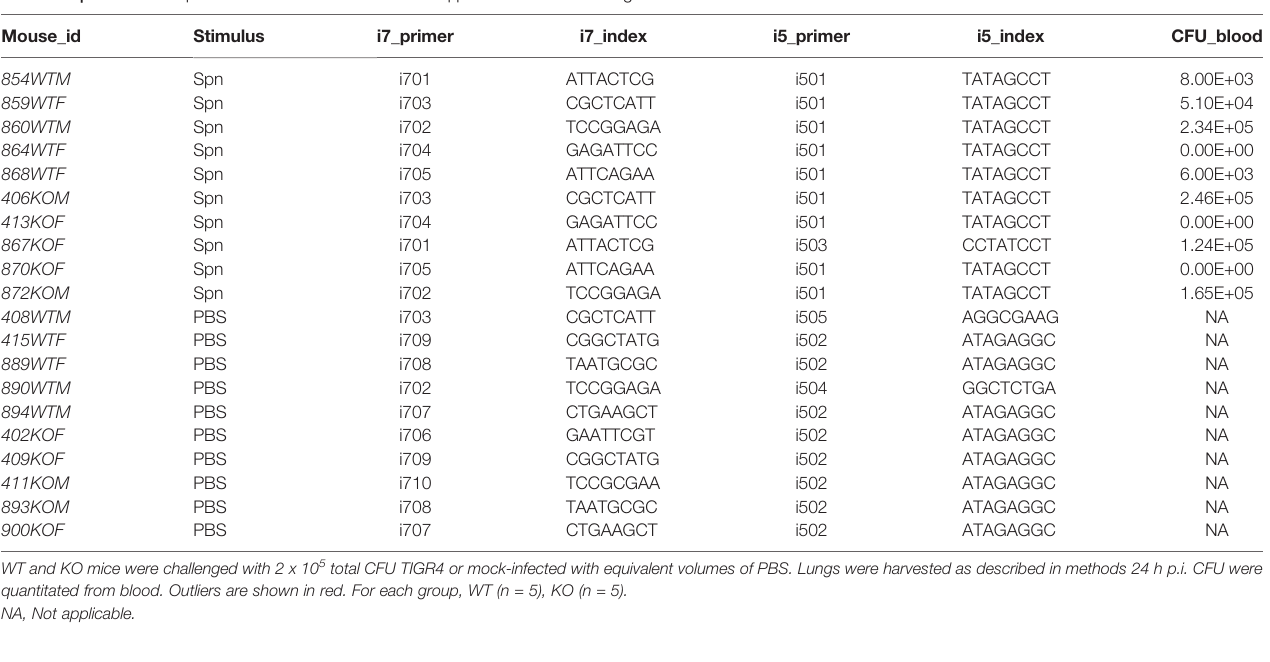
TABLE 1 | CFU counts per individual mice used in RNAseq pneumococcal challenges.